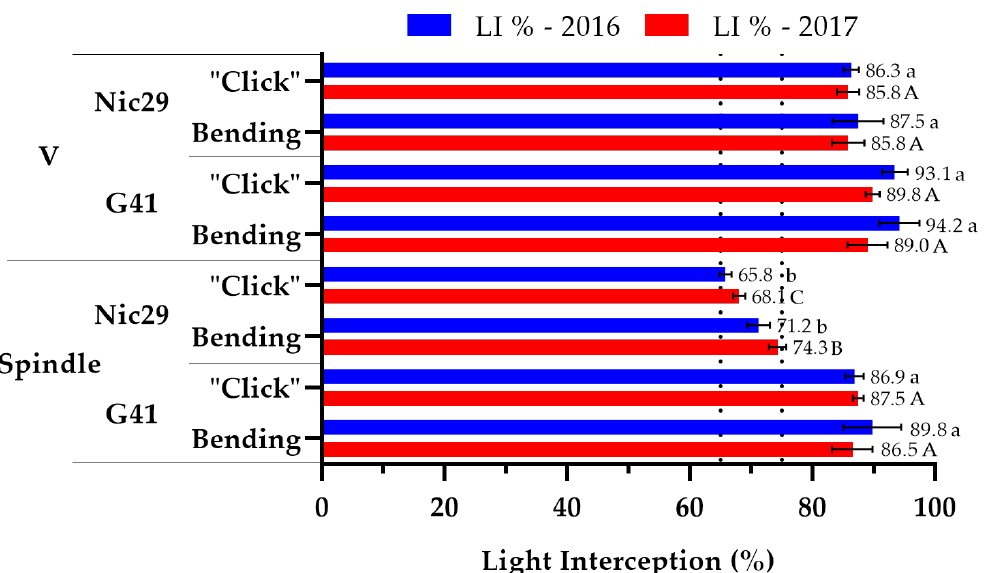
Figure 3. Average light interception (LI %) at 20 cm (2016) and 40 cm (2017) from each trial tree across all treatment combinations in the summer (June–August) for “WA38” trees grown in Washington State in 2016 and 2017. ANOVA indicated significance: *** ( p < 0.001) for both 2016 (lower-cased letters) and 2017 (upper-cased letters). Student–Newman–Keuls (SNK) test for mean comparisons. Means to the right of each bar in the chart with the same letter indicate non-significance at p -value < 0.05. Dashed vertical black lines indicate minimum and maximum LI % optimal thresholds based on literature. Errors bars ± SE, N = 11 trees for Spindle plots, N = 10 trees for V plots.